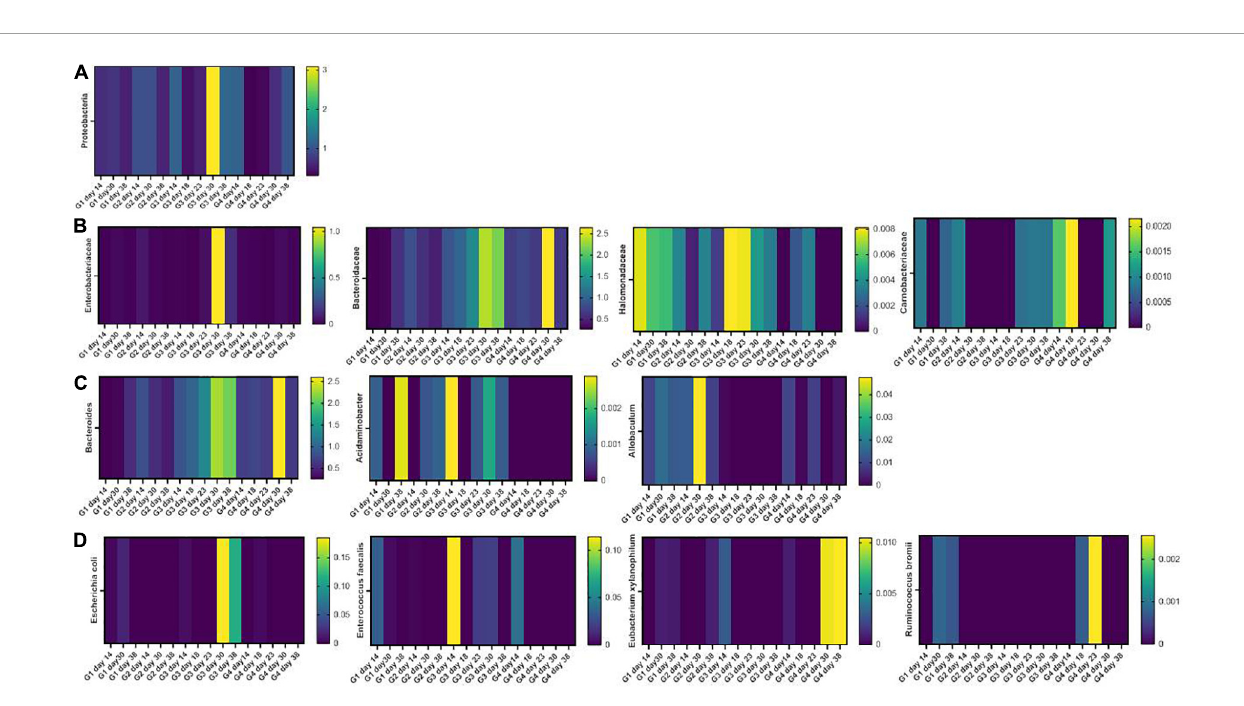
day 38 = 0.13112%) while remaining less abundant in mice of G4 receiving DSS + Paniculin 13 TM (day 23 = 0%, day 30 = 0.02845% and day 38 =